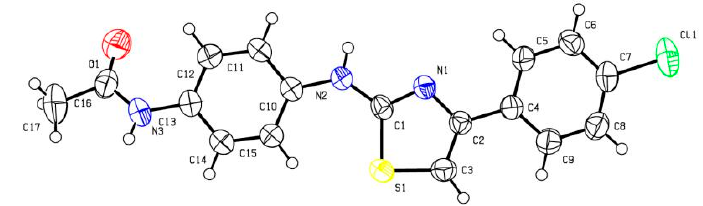
Figure 2. Crystal structure of compound A 4.